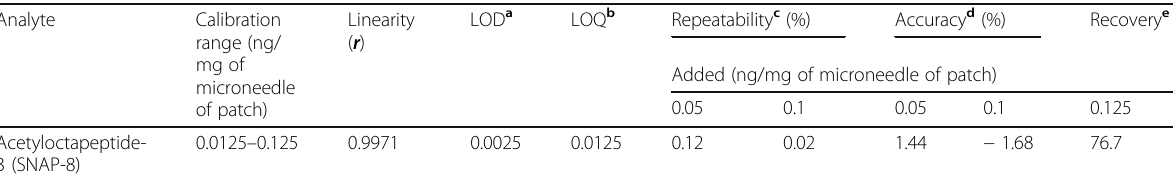
Table 3 Validation data set of SNAP-8 by LC-MS/MS Analyte